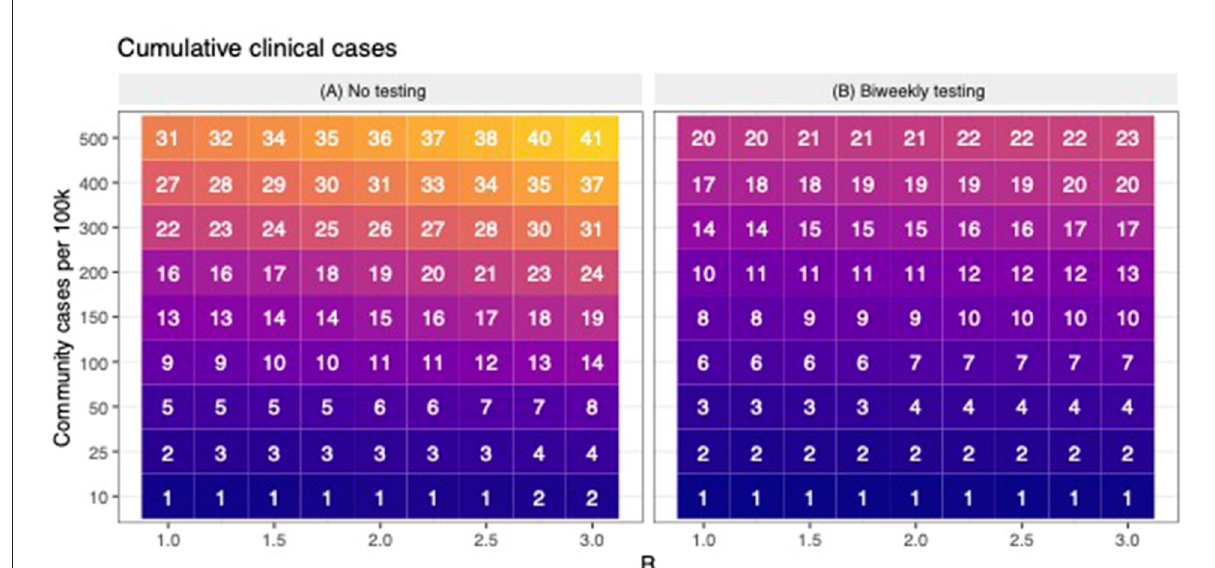
FIGURE1 The cumulative number of expected clinical cases when there is no testing and during bi-weekly testing. (A) shows the predicted number of cumulative clinical cases (in a population of 100) across scenarios with variable levels of workplace R and community transmission. For the same levels of workplace R and community transmission as (A,B) shows the predicted number of cumulative clinical cases when bi-weekly testing was employed. Across (A,B) , lower to higher numbers are shaded in darker to lighter colors, respectively.